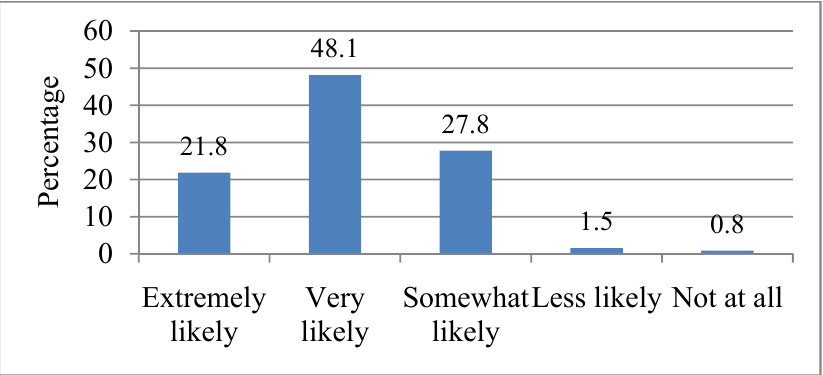
Figure 9. Respondents’ attitudes towards potential consequences of heat waves. Q9. If heat waves were to increase in future, how likely do you think this will have consequences in